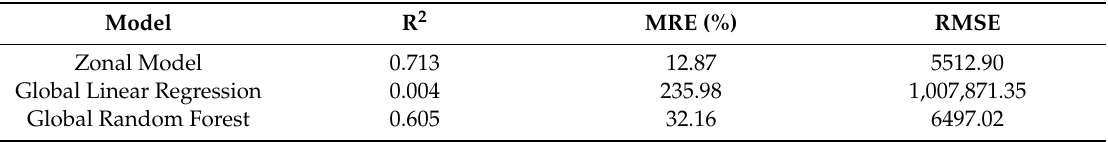
Table 7. Model accuracy in the whole area.